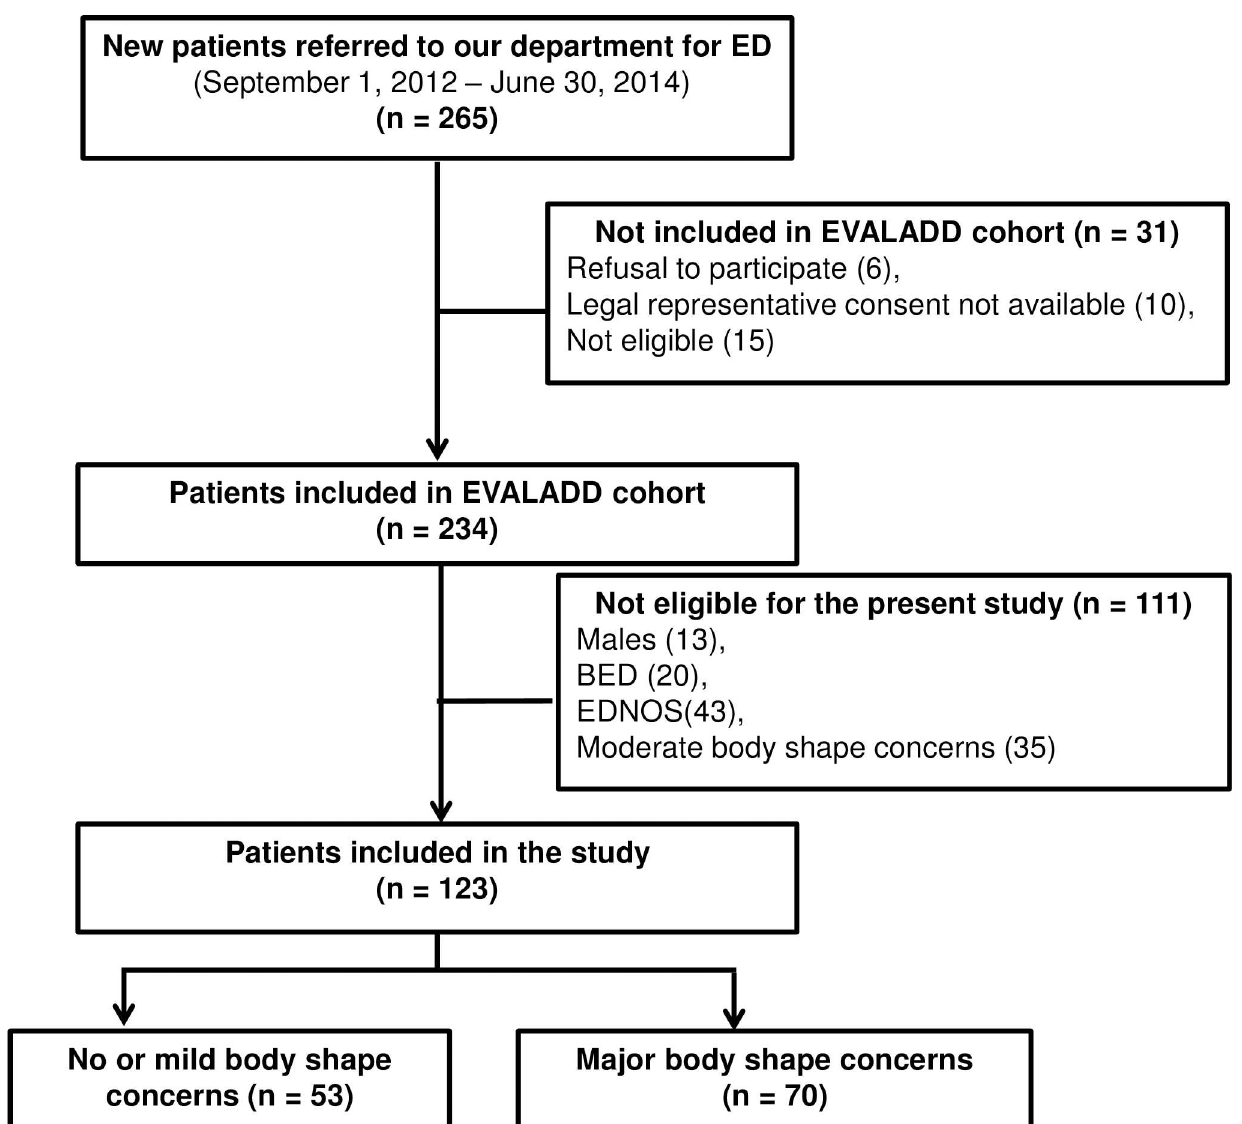
Fig 1. Flow chart of patient selection. (n) Number of patients includedor excludedat each step of the inclusionprocess. (BED) Binge Eating Disorder. (EDNOS) Eating DisordersNot Otherwise Specified.